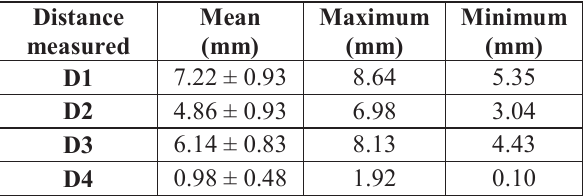
Table-2: Measurements of trochlear spine and fovea in frontal plane